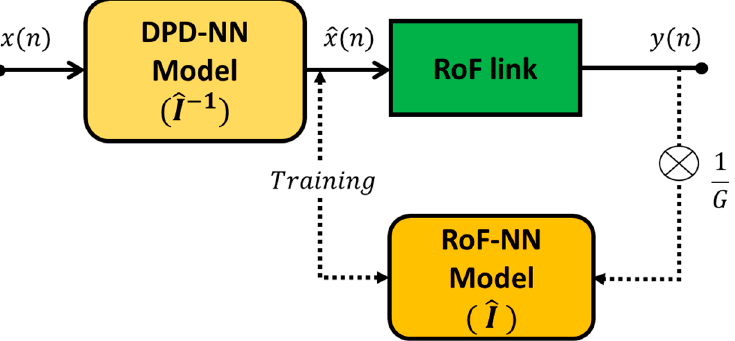
Figure 3. Schematic showing RoF system utilizing a neural network (NN) digital predistortion (DPD) system and RoF NN model. After transmitting through the RoF link, the input and output of RoF are used to model RoF NN model ˆ I . Once trained, by backpropagating the error through ˆ I , training of I − 1 is performed. This DPD RoF model is then used with the RoF link to perform linearization. Predistortion is carried out in a digital baseband so ADC and DACs are omitted.